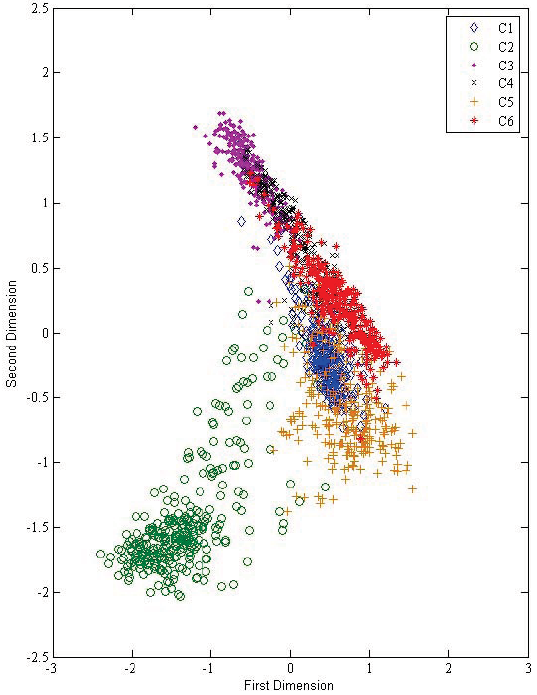
Figure 2. Classification result of the MMI